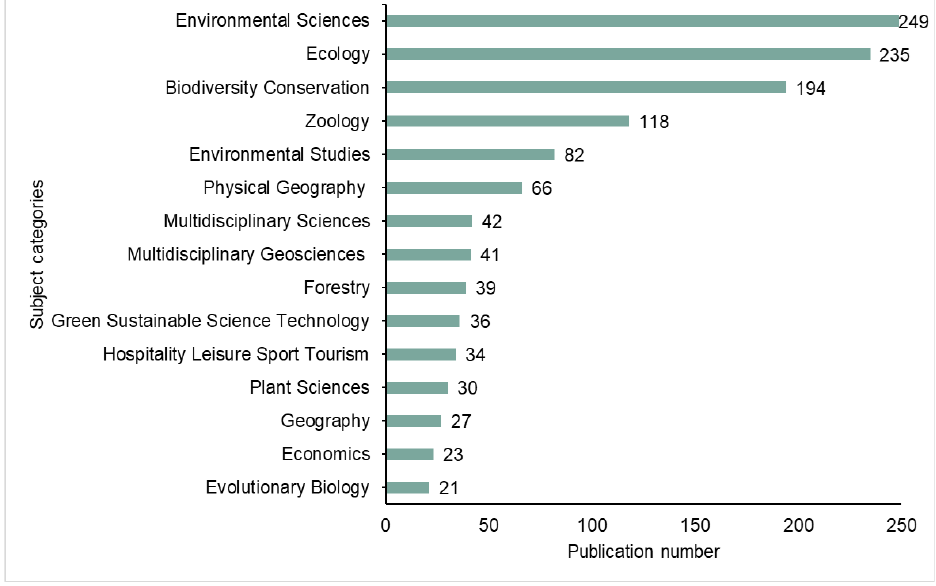
Figure 3. Research categories.